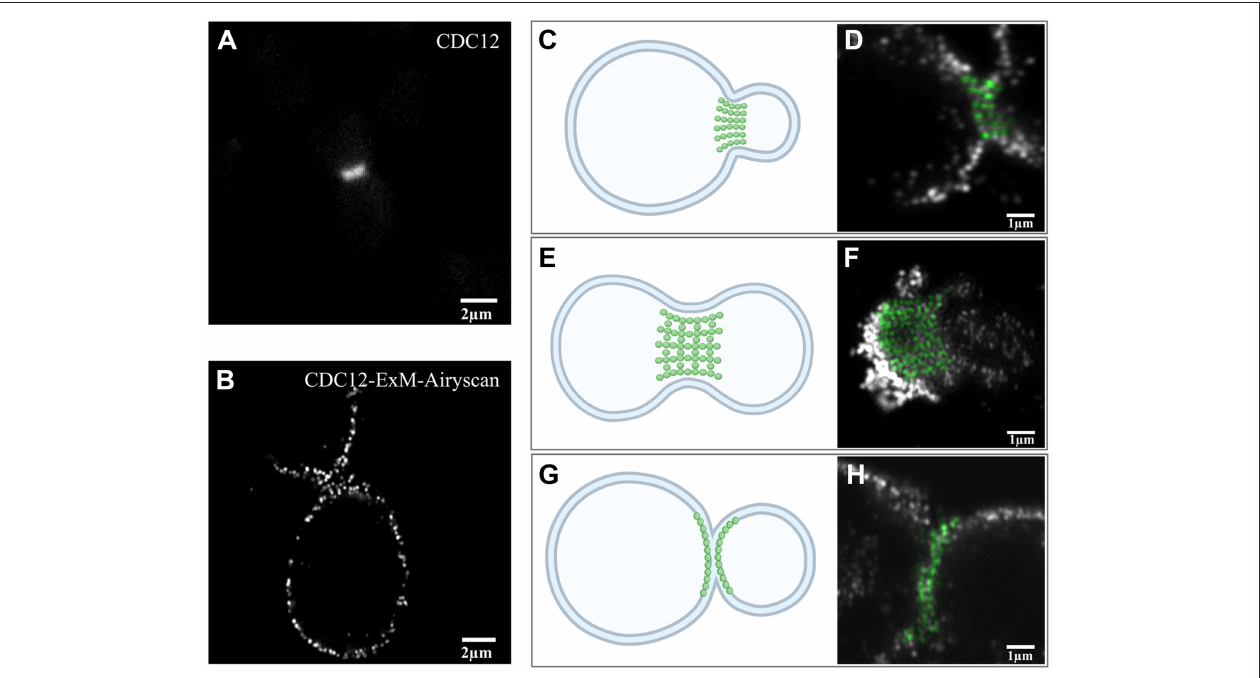
FIGURE 3 | Expansion images of septin-CDC12 in three different stages. (A) Pre-expansion wide-field imaging of septin CDC12. (B) Post-expansion Airyscan imaging of septin CDC 12. Diagram (C) and Airyscan image (D) of the early stages of yeast cell division. Graph (E) and image via Airyscan (F) of septin in the transition stage prior to ring splitting. Illustration (G) and Airyscan image (H) represented septin during the double-ring stage. The green dots in this figure (D,H) were pseudo-colors stand for the cdc12 at the division interface. Scale bar, 2 µ m (A,B) and 1 µ m (D,F,H) . All bars were physical scales before correction with expansion factor. The expansion factor is